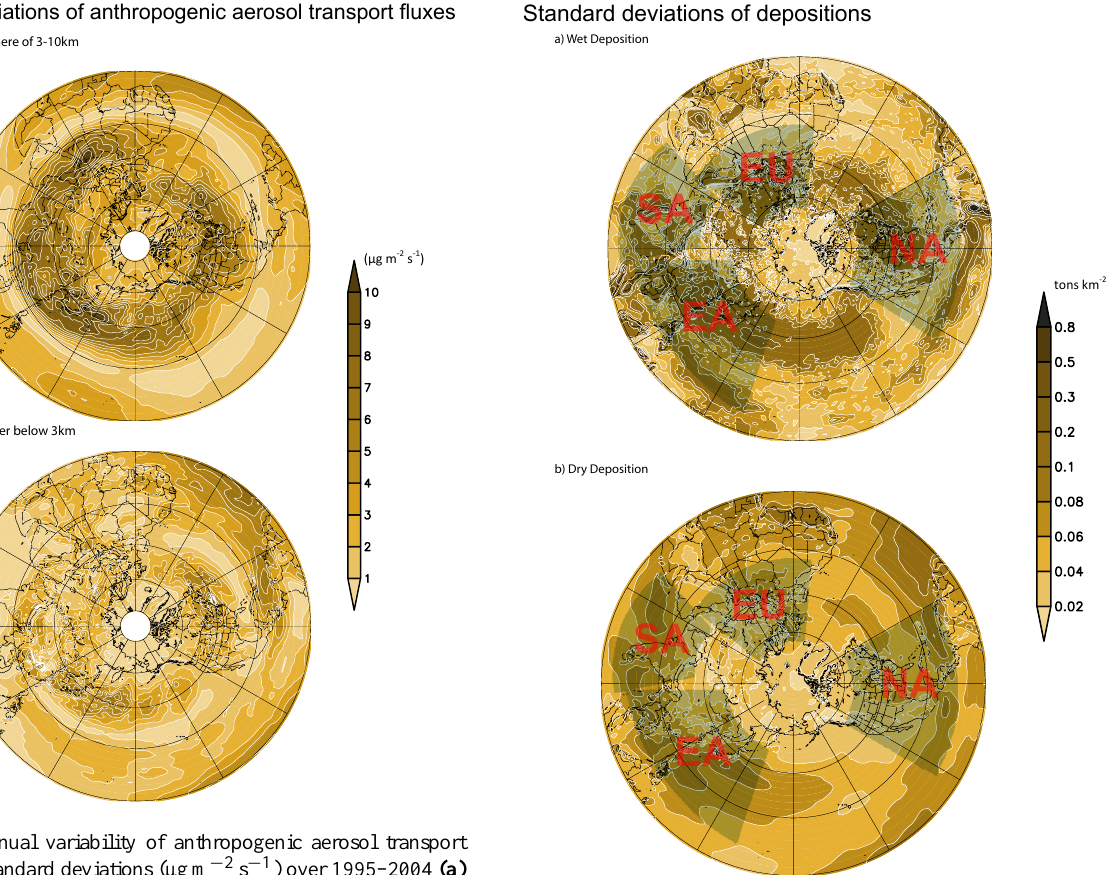
aerosol depositions in the standard deviations (tonskm − 2 ) averaged over 1995–2004. The shaded boxes indicate four HTAP-regions (Table